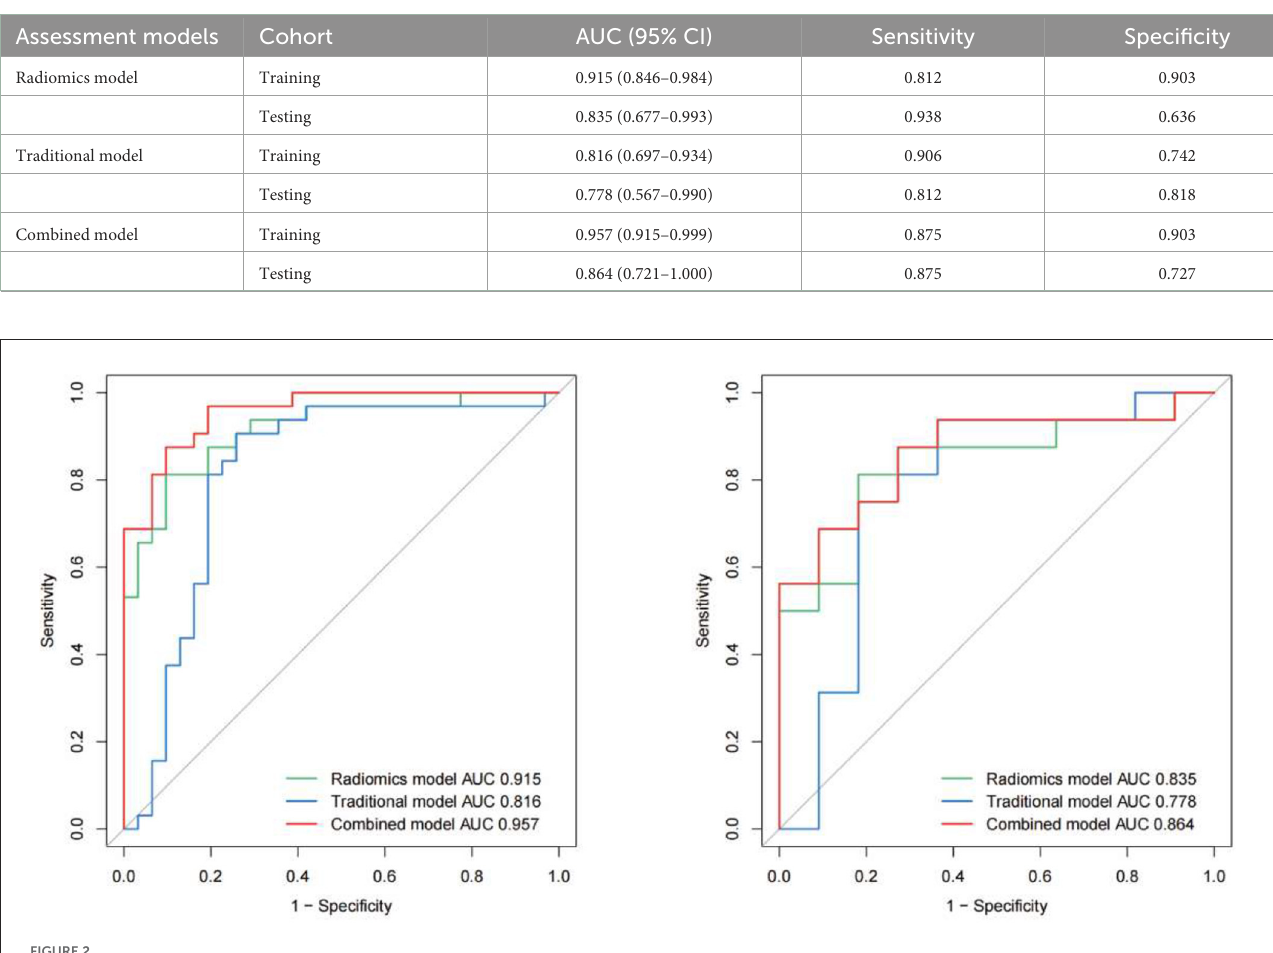
FIGURE2 Receiver operating characteristic (ROC) curves of all the models (traditional model, radiomics model and combined model) in the training and test cohorts